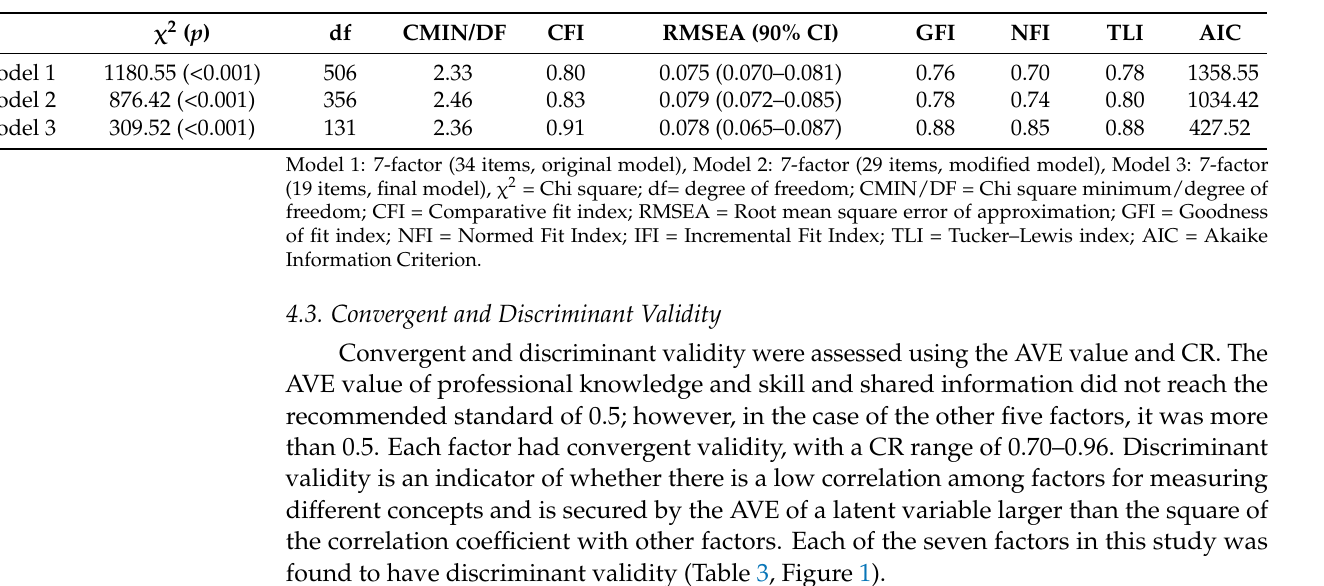
Table 2. The Model Fit Indices for the PNPPS-PN.